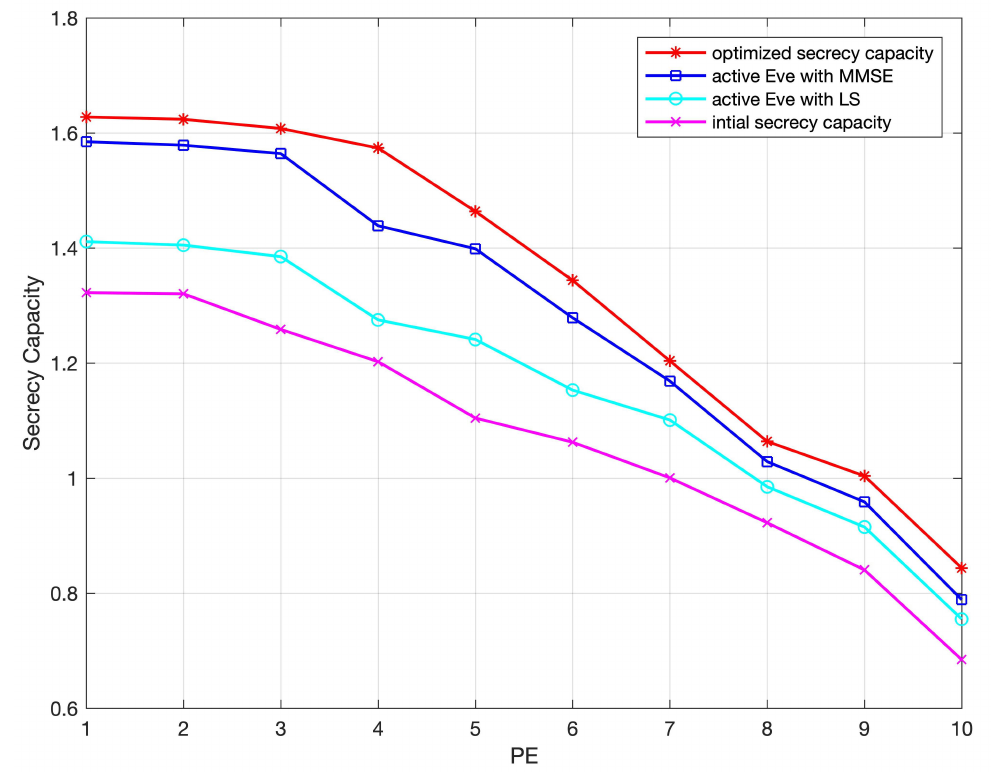
Figure 7. SCO − AN’s Secrecy Capacity Before and After Power Allocation versus Different P E and Channel Estimation